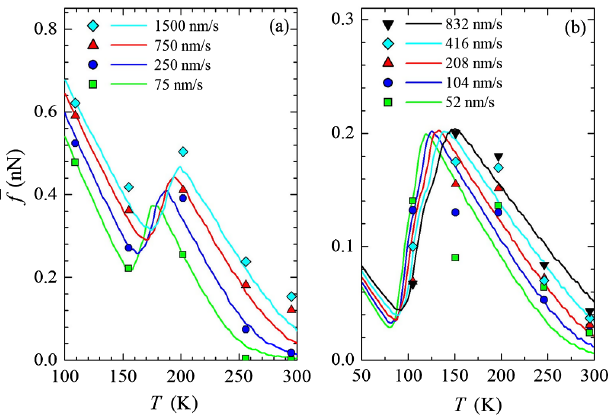
(cid:4) f 3. Mean friction force versus temperature T for various pulling velocities v . Symbols: Experimental data ex- tracted from (a) Fig. 4a of Ref. [7] (HOPG substrate) and (b) Fig. 1c of Ref. [6] (NaCl substrate). Lines: Numerically obtained solutions of the theoretical model (1)–(5). (cid:4) f FIG. 4. Mean friction force versus pulling velocity v for various temperatures T . Symbols: Data from the same experiments as in Fig. 3. Lines: Theory (1)–(5) with the same parameters as in Fig.